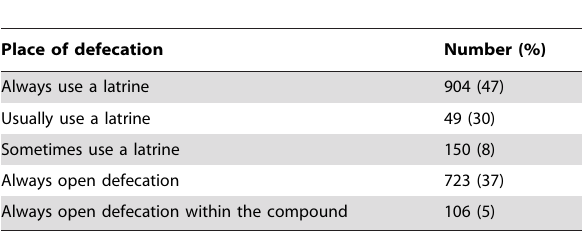
Table 4. Reported place of defecation for individuals in households where there is a latrine N=